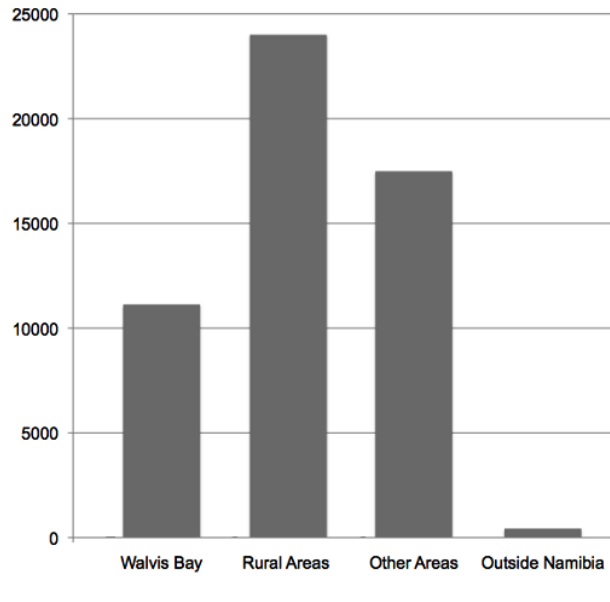
Fig. 2 . Origin of heads of households in Walvis Bay, Namibia. Data adapted from Tapscott